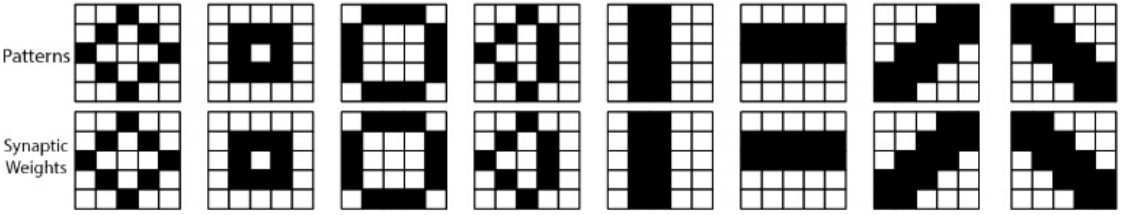
Figure 10. The applied pa tt erns and synaptic weights for the proposed architecture of the WTA.